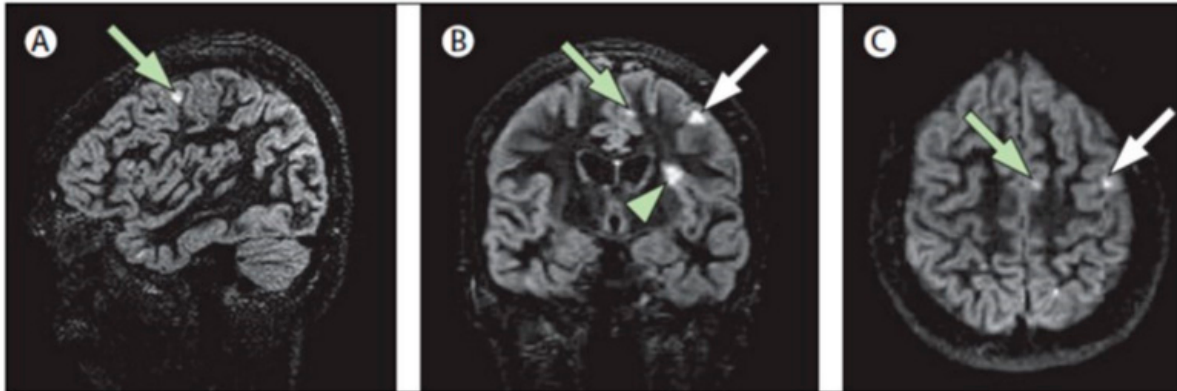
Figure 2. Multiplanar representation of single-slab 3D double-inversion recovery images of a patient with MS. ( A ) Sagittal view of a juxtacortical lesion (arrow) in the frontal vertex. ( B ) Coronal orientation: same wedge-shaped juxtacortical lesion (white arrow), as well as a mixed grey matter–white matter (type I) lesion (arrowhead) near the frontal operculum and a smaller juxtacortical lesion frontomedially (green arrow). ( C ) Same two juxtacortical lesions as shown in ( A , B ), in the axial orientation. Reprinted from The Lancet Neurology , Vol. 7, Issue 9, P841–851, 1 September 2008 [60]. Copyright: © 2021, with permission from Elsevier.